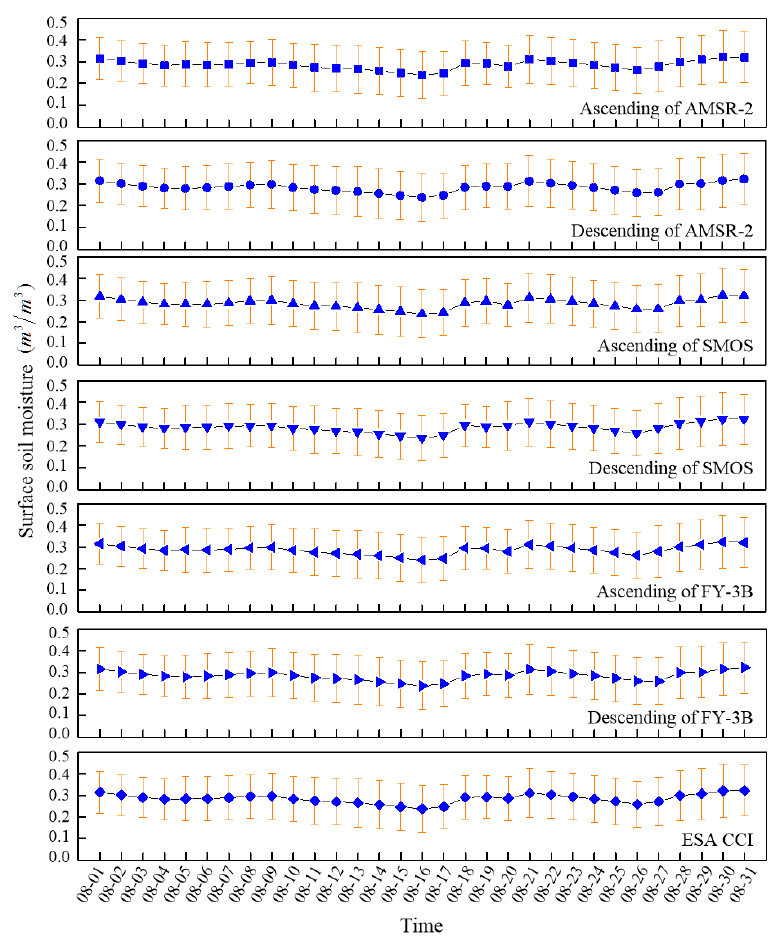
Figure 2. Daily SSM values for each coarse surface soil moisture (SSM) product during August 2012 in Naqu area. Dots denote the average value and the bars denote ±1 standard deviation.